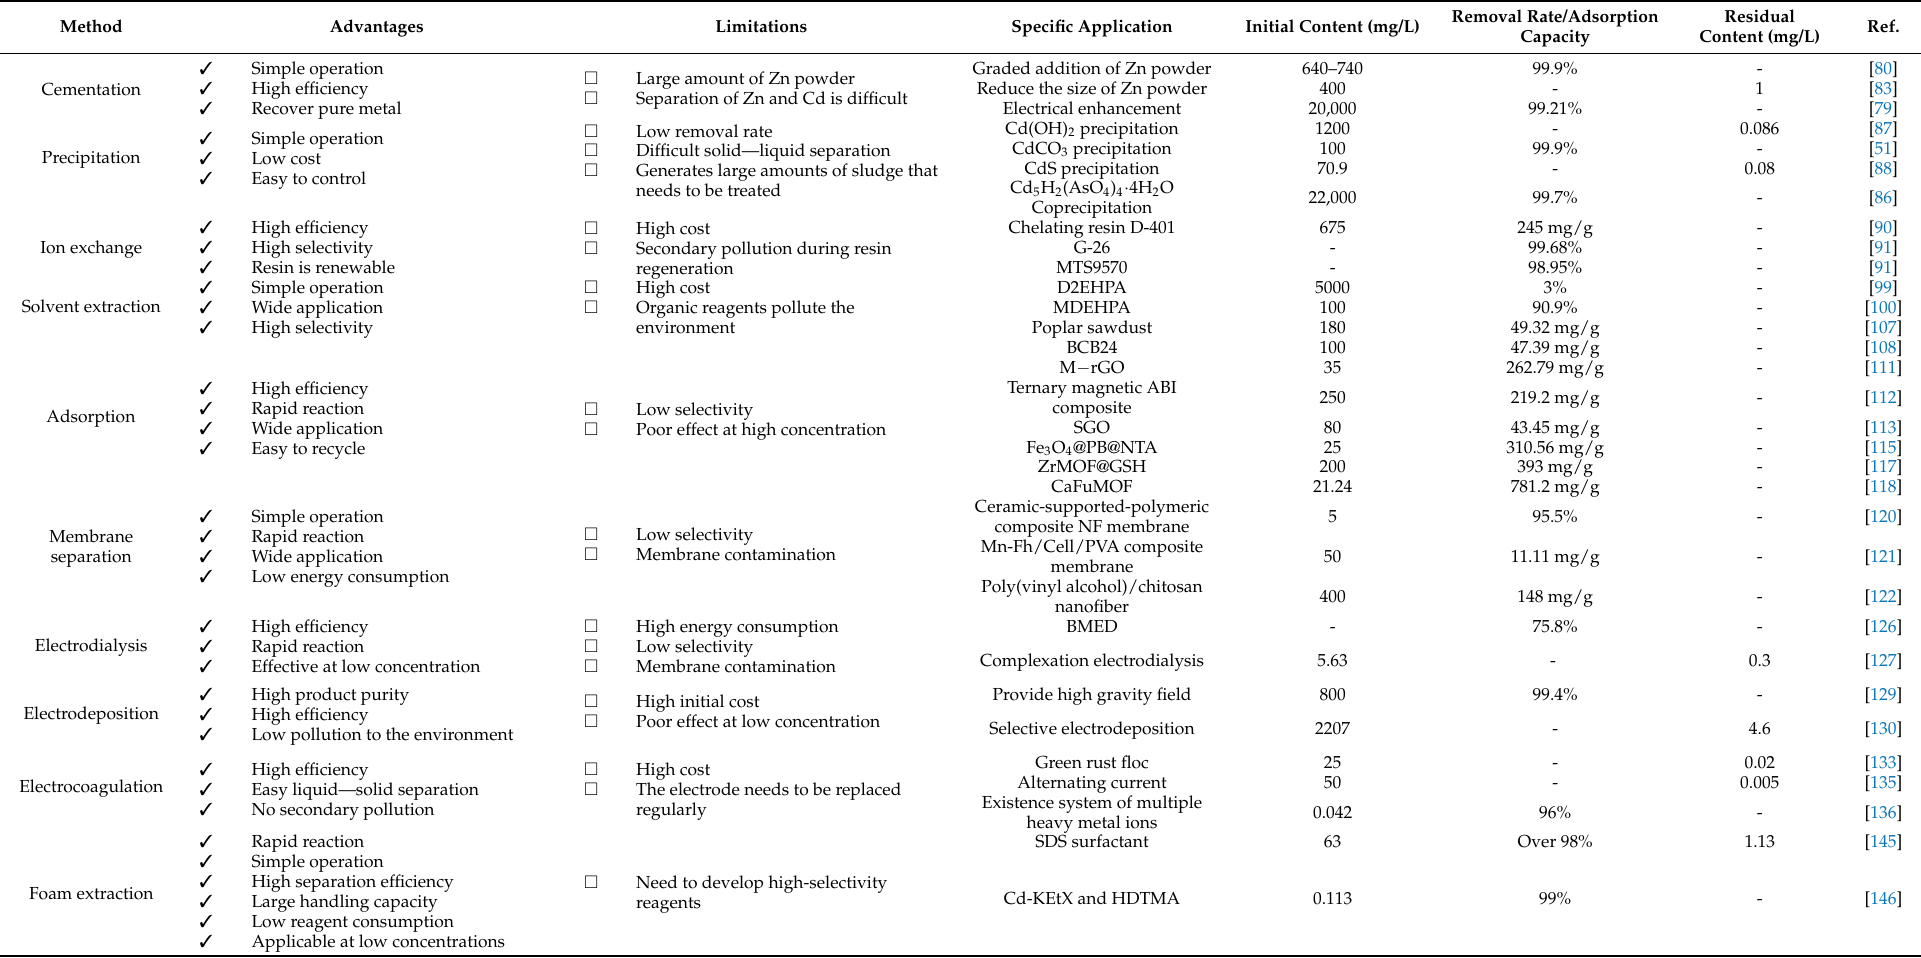
Table 2. Comparison of the advantages, limitations, and specific applications of methods for the removal and recovery of Cd from waste solutions.